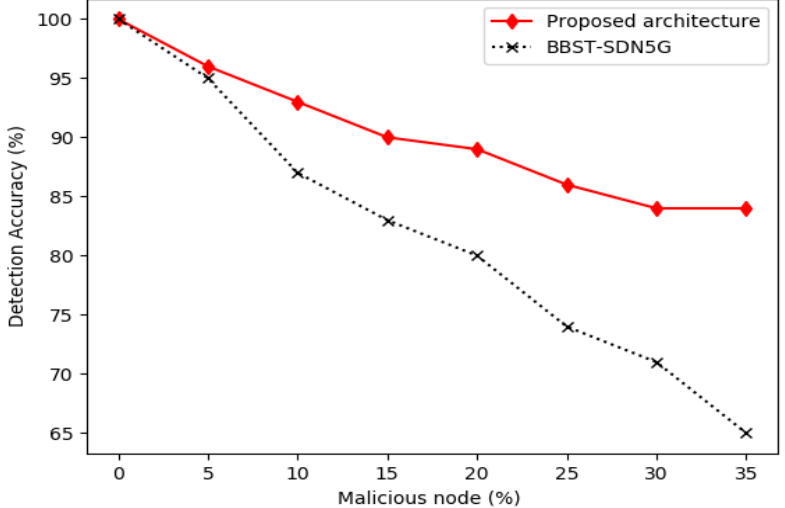
Figure 5. Detection accuracy of malicious nodes